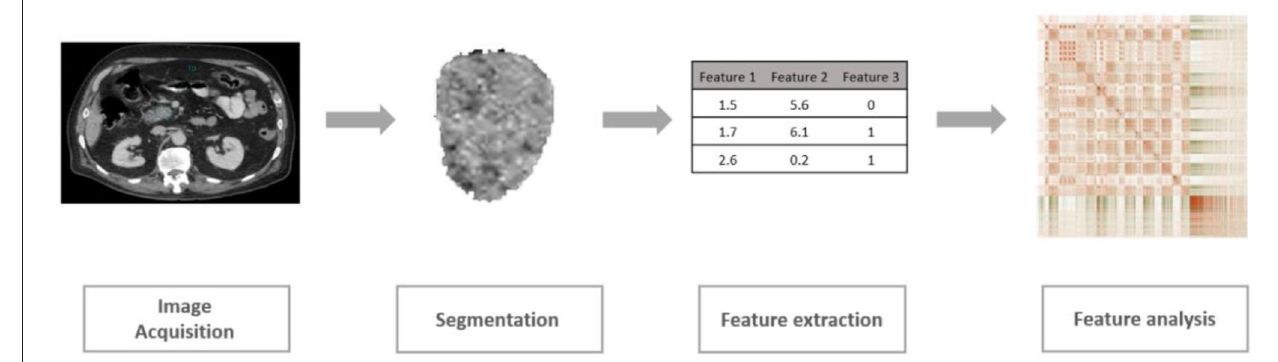
FIGURE 1 | Conventional radiomics analytics pipeline.